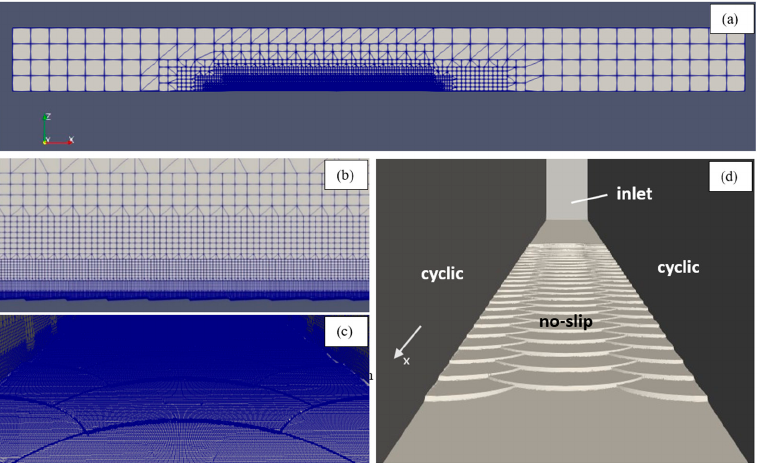
Figure 5. ( a ) Full domain, lateral view; ( b ) detail on scale pattern mesh refinement, ( c ) perspective, ( d ) boundary conditions.